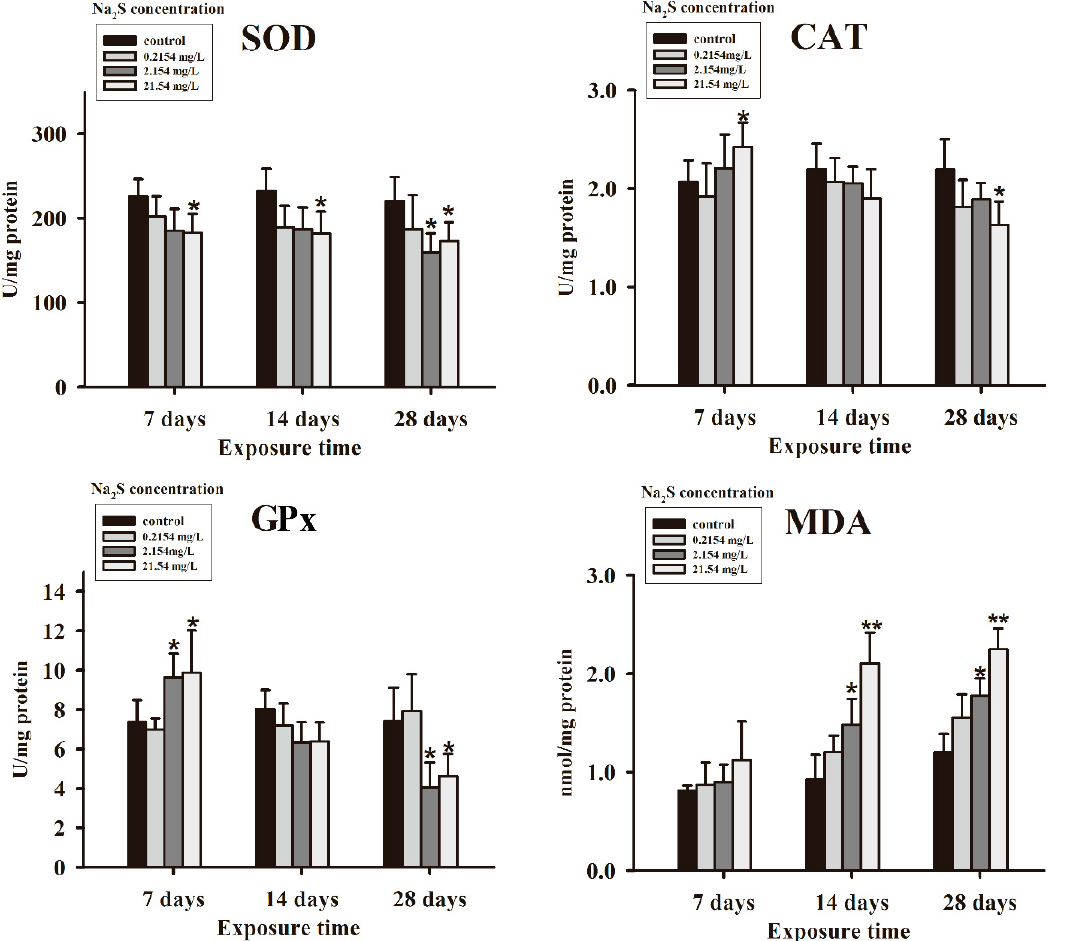
Figure 1. The changes in the oxidative stress parameters (SOD, CAT, GPx, and MDA) in the liver of rice field eel after exposure to 0, 0.2154, 2.154, and 21.54 mg/L Na 2 S for 7, 14, and 28 days. The results are shown as the mean ± SD of six replicates. * p < 0.05, ** p < 0.01 indicate the statistically significant differences between the exposure and control groups.